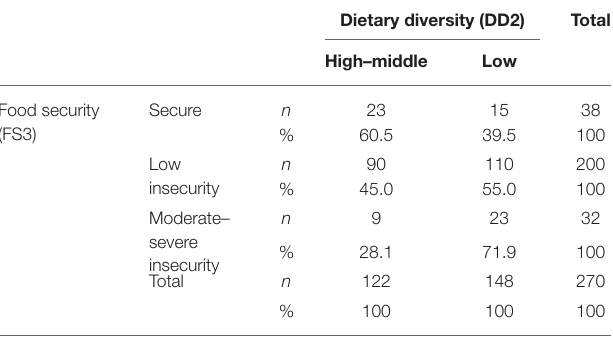
TABLE 5 | Student’s distribution between FS3 and DD2 categories. Dietary diversity